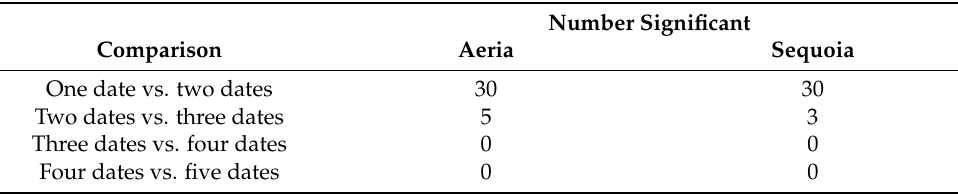
Figure 2. The three best single- and multi-date image combinations based on the overall accuracy for ( a ) the normal color Aeria sensor and ( b ) the multispectral Parrot Sequoia sensor. The bars are grouped by the number of images in the image stack. Table 5. Results of the mono- versus multi-temporal kappa comparisons for the Aeria and Sequoia. The date combination with the highest overall accuracy within each sensor was used for each com- parison. The value represented the number of iterations out of 30 that were found to be significantly different at the 95% confidence